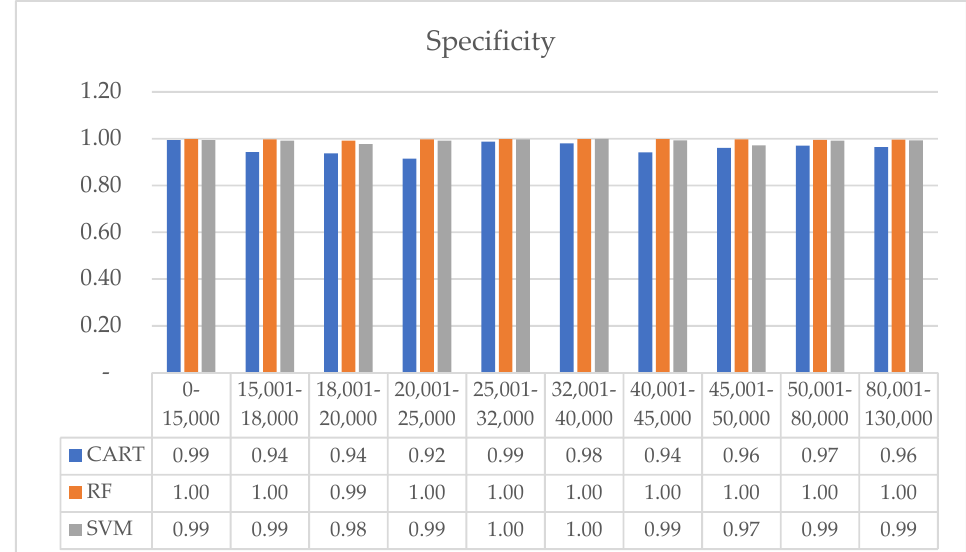
Figure 8. Specificity values distribution of all models. Figure 9 shows the positive prediction values distribution of all models. At all land value estimation levels, RF and SVM models were found to have high positive prediction values. Except those at levels 15,001–18,000 THB/Wah 2 and 50,001–80,000 THB/Wah 2 , SVM was noticeably less than the RF model, while with the CART model, positive prediction values were poor.